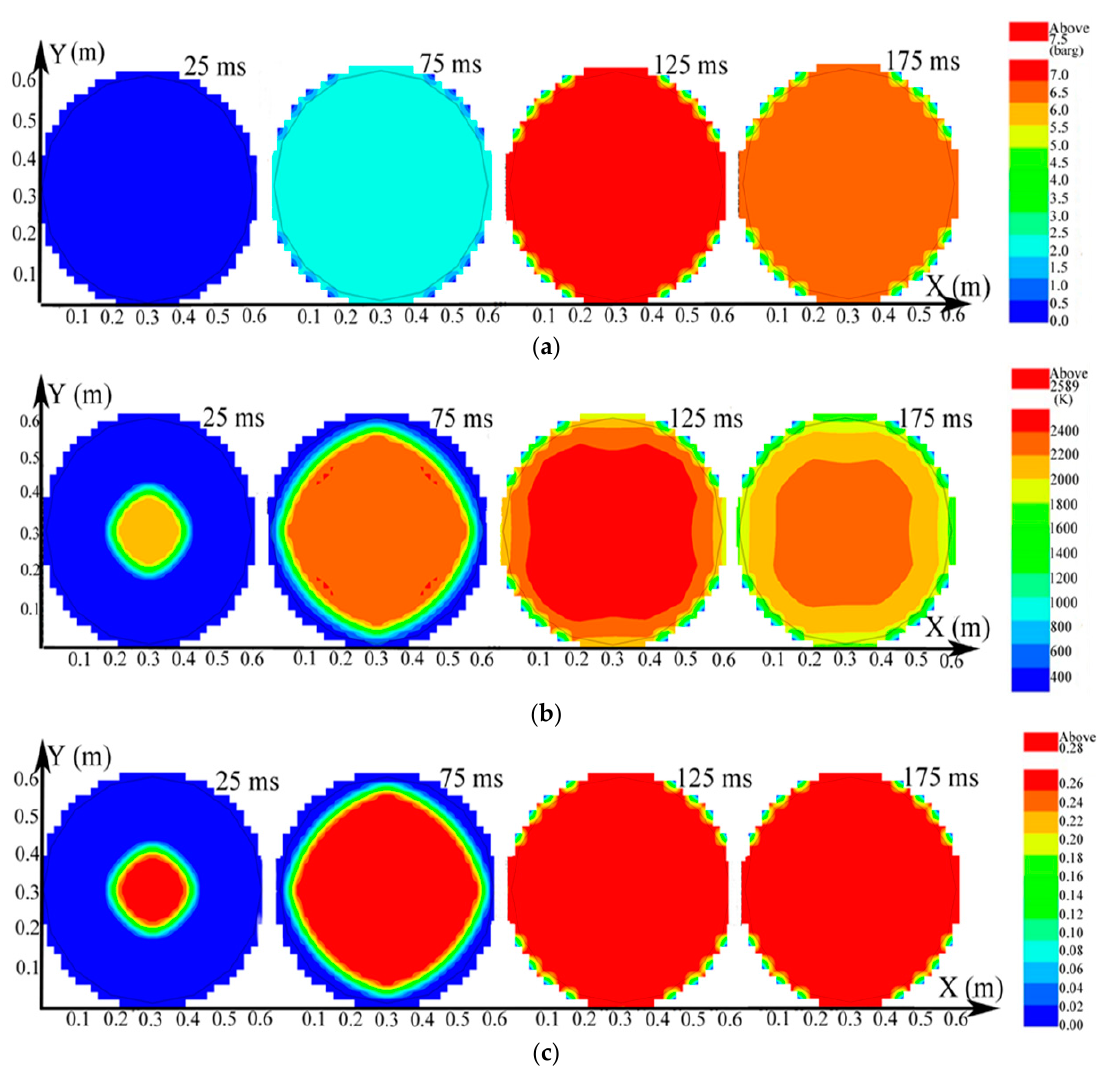
Figure 4. Contours of the natural gas explosion parameters containing pressure, temperature, and concentration of products in the larger vessel. ( a ) Distribution of pressure; ( b ) distribution of temperature; ( c ) distribution of the concentration of products.